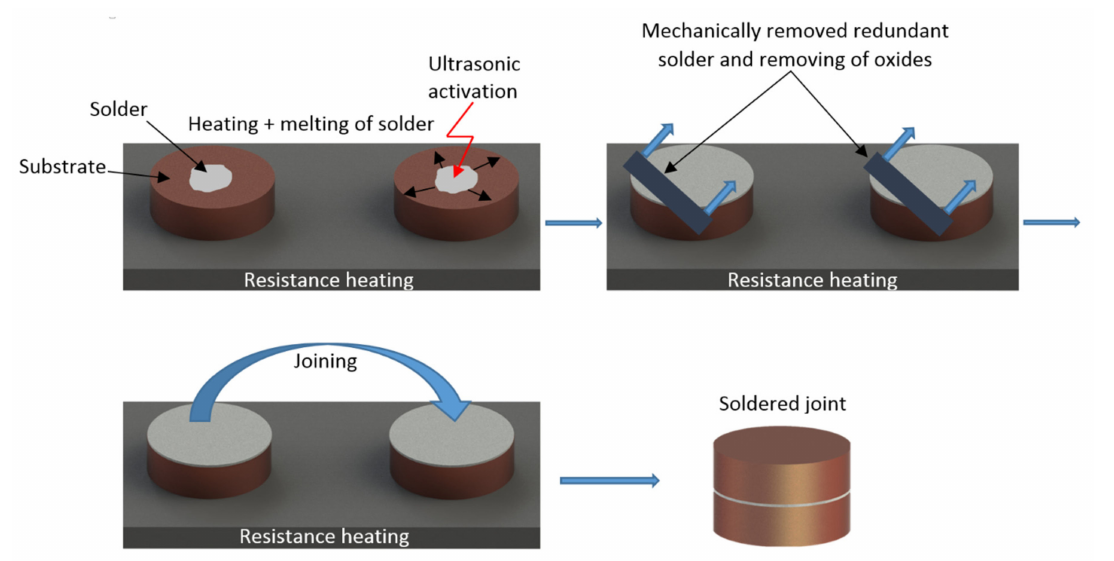
Figure 2. Schematic representation of the soldering process in the presence of ultrasonic power.